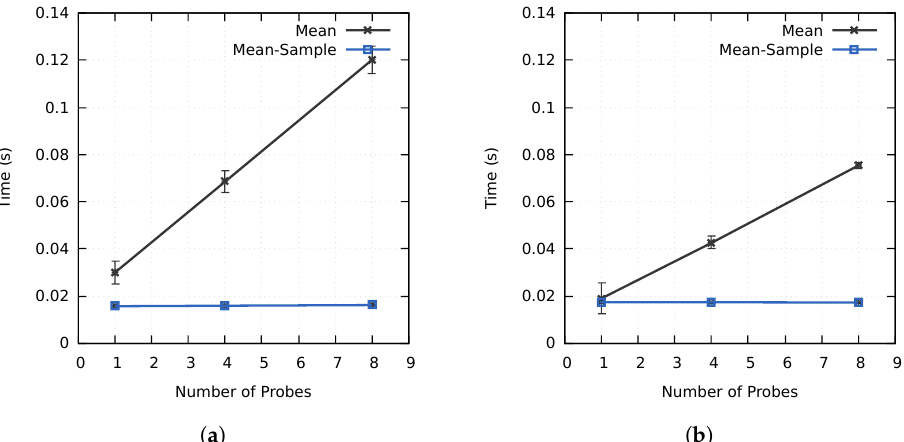
Figure 6. The average importance calculation times using up to eight Mean probes on ( a ) clus- ter A and ( b ) cluster B for the MF data set. The error bars display the standard deviation of the computation times. Table 3. Accuracy of the sampled probes. Percentage of all sampled block importance values which absolute error is less than 0.001, 0.005, 0.01, 0.05, and 0.1. Tests were run on cluster A, using the MF data set and time step 80. The AVGSEQ probe is not included, as it is only used on non-sampled